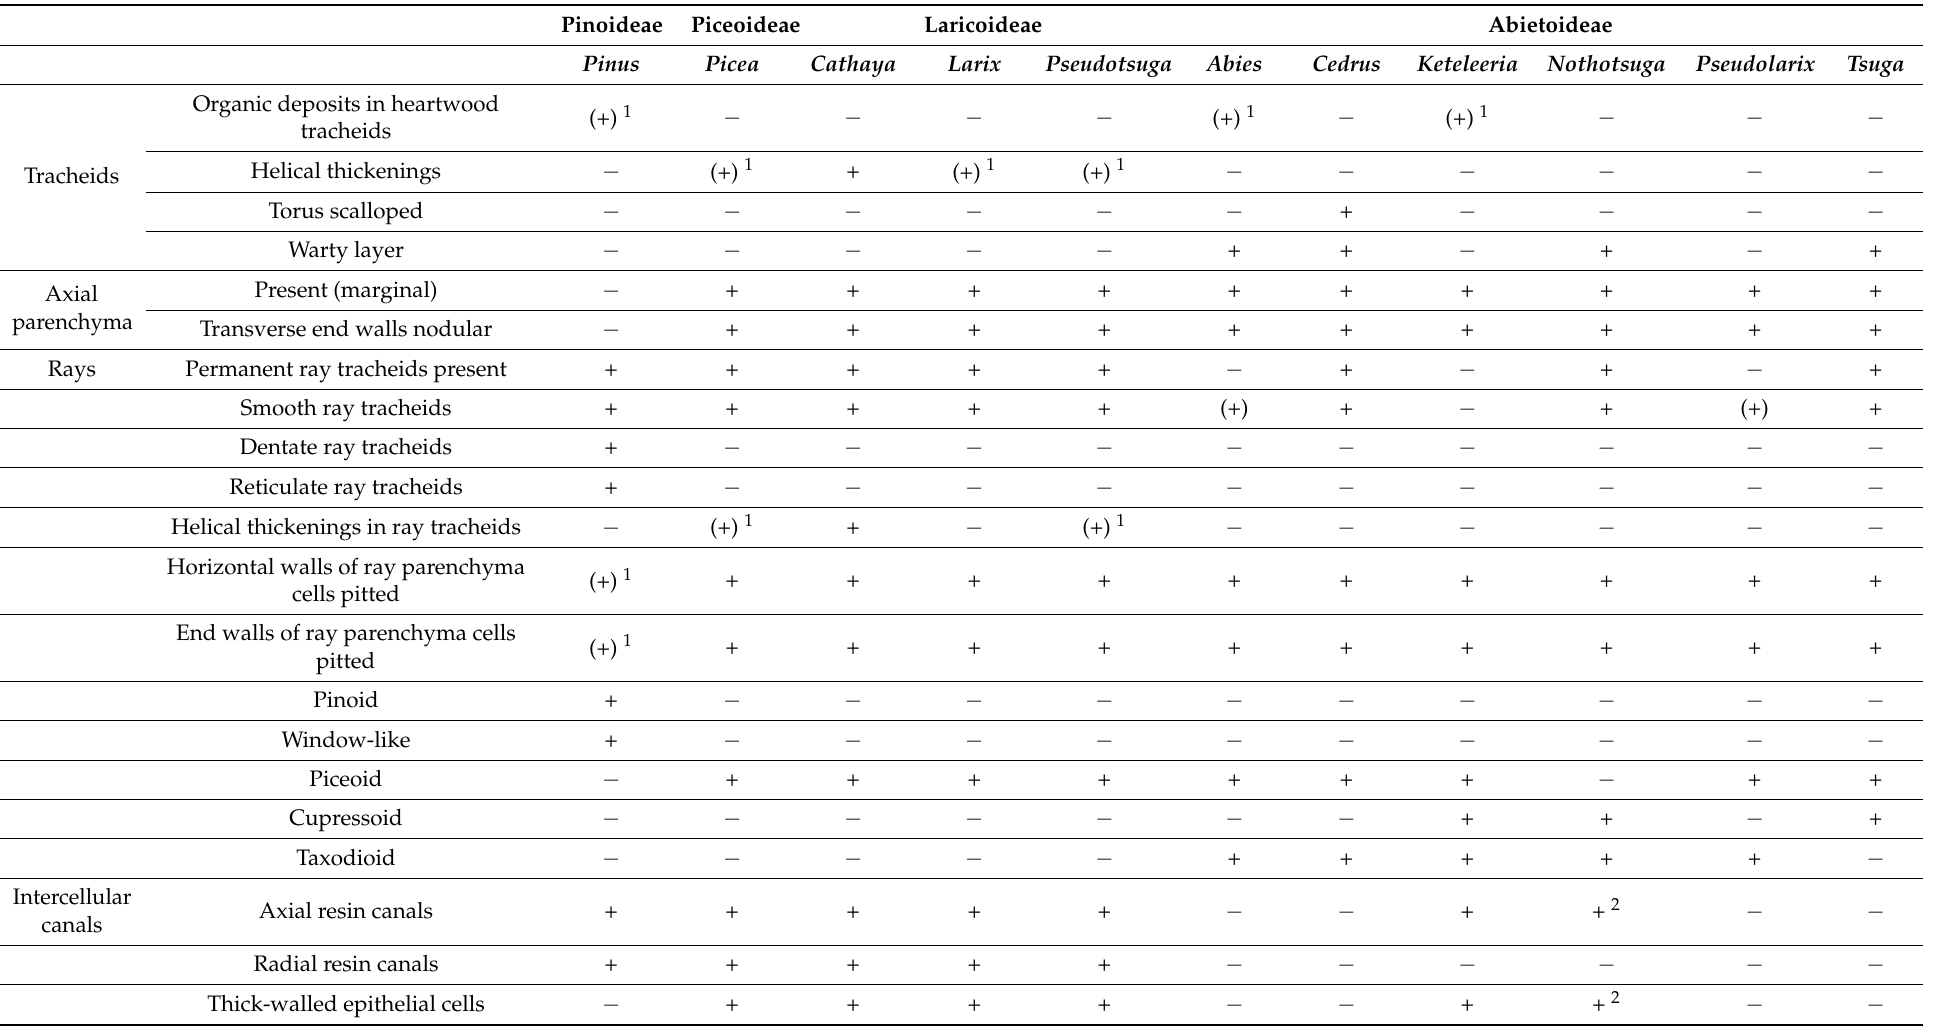
Table 1. Summary of features by genus based on the species studied. + Present, − Absent, (+)